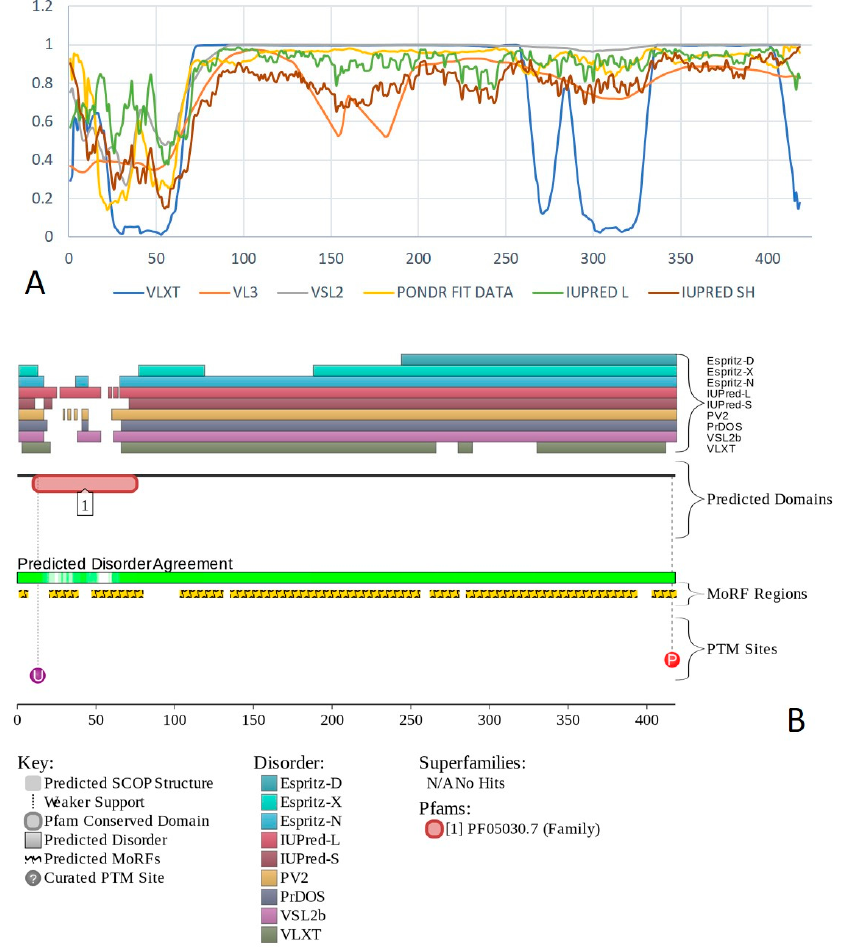
Figure 16. Structural and functional analysis of the human SSXT protein (UniProt ID: Q15532). ( A ) Intrinsic disorder profile of human SSXT protein generated by six commonly used predictors of intrinsic disorder (PONDR ® VLXT, PONDR ® VL3, PONDR ® VSL2, PONDR ® FIT, IUPred_short, and IUPred_long). ( B ) D 2 P 2 functional disorder profile of the human SSXT protein. 2.14. BAF200/ARID2 (PPID = 61.3%)